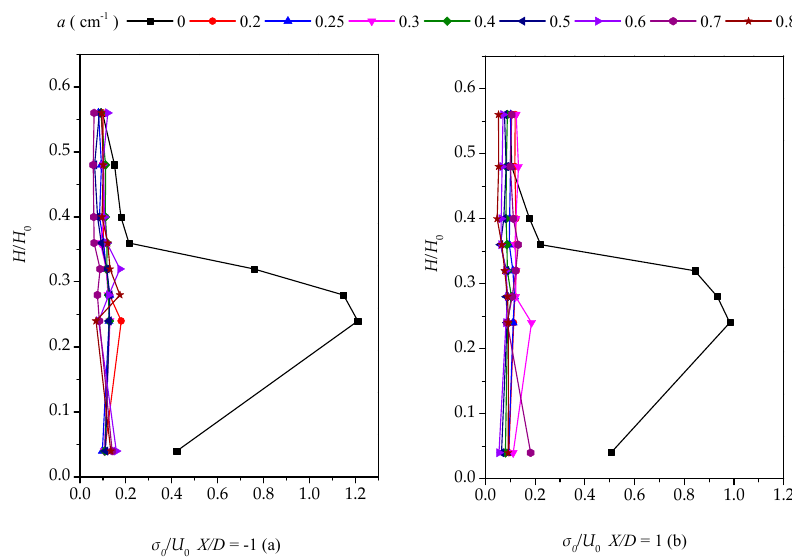
Figure 7. The vertical distribution of the turbulence intensity.